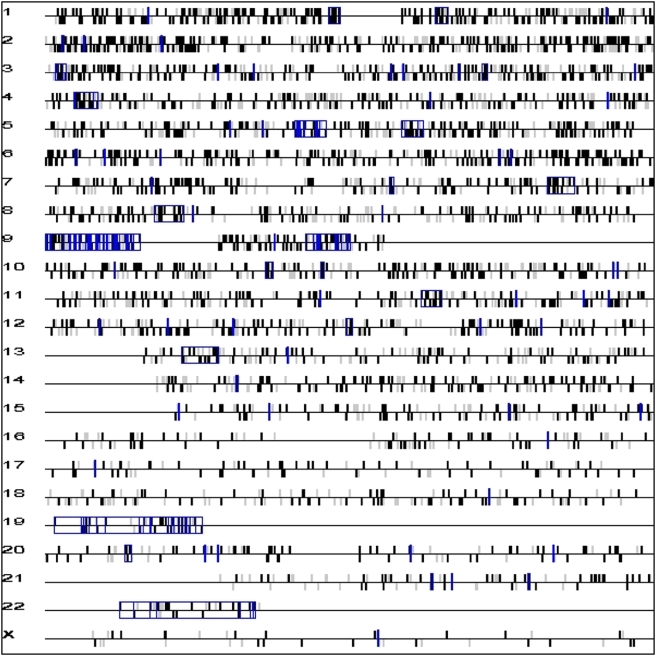
Chromosome mapping of heterozygous SNPs expressed in PBMCs.The position of each SNP on the chromosome is based on the annotation in dbSNP (version 126, May 2006). Differentially expressed SNP alleles are coloured in black. The vertical bar above the horizontal line means the SNP is on the forward strand, the one below means that it is on the reverse strand. SNP stretches with a p-value<0.00005 are highlighted in blue boxes.